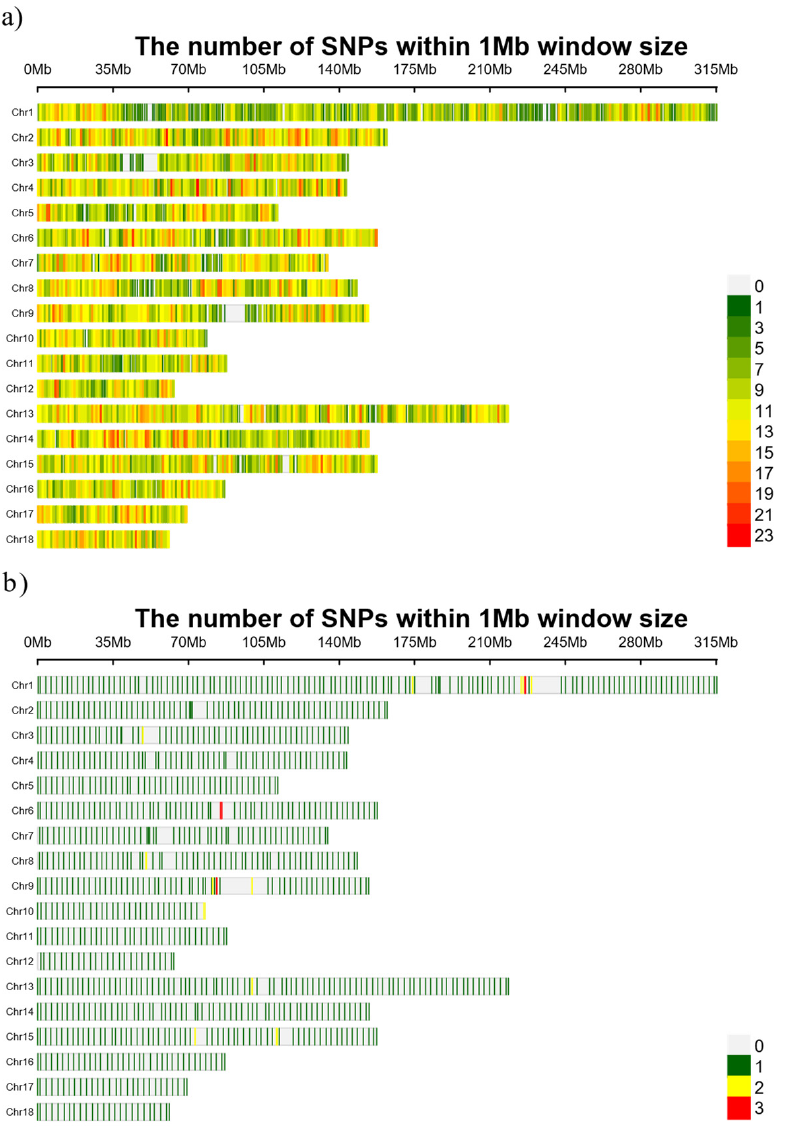
Figure 1. Distribution of SNPs on the genome. ( a ) Distribution of SNPs in the raw chip, ( b ) Distribu- tion of SNPs in the 1K chip designed with “block-free” method. One vertical line corresponds to the number of SNPs in 1 Mb length and the numbers represented by different colors are as shown to the right of the figure.